Question: State the chart type depicted above.
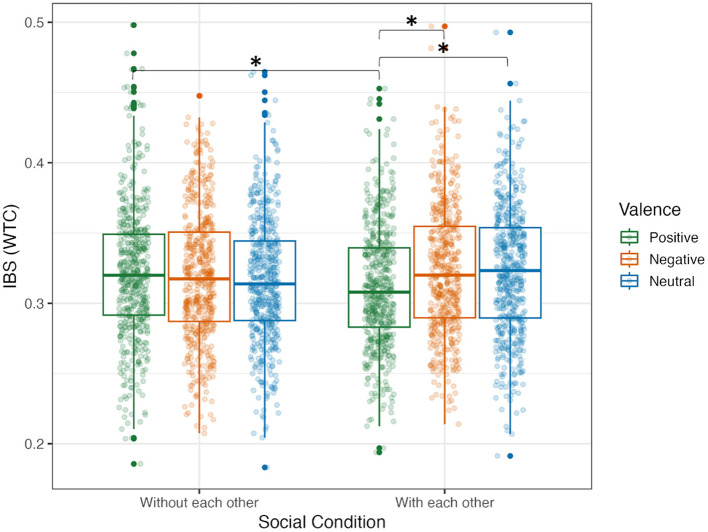
Answer: box